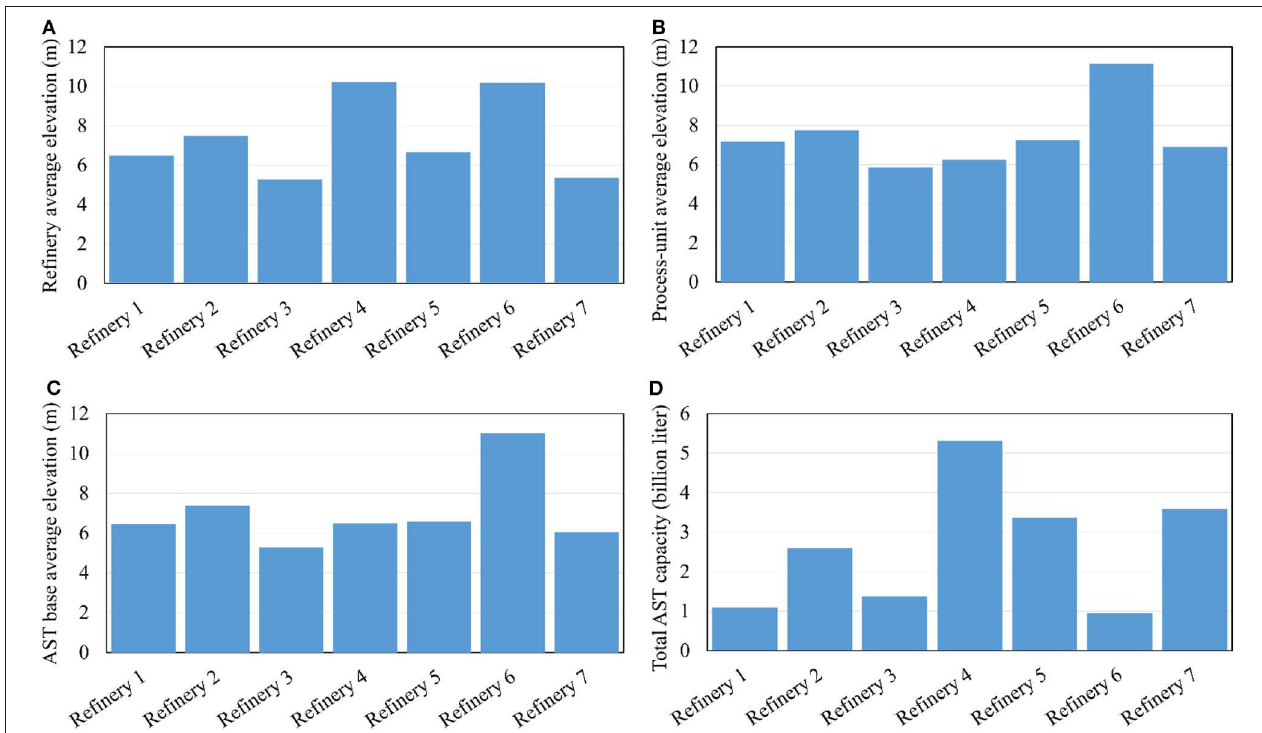
FIGURE 9 | Comparison of the refineries’ features: (A) Refinery average elevation, (B) Process-unit average elevation, (C) AST base average elevation, (D) storage capacity.